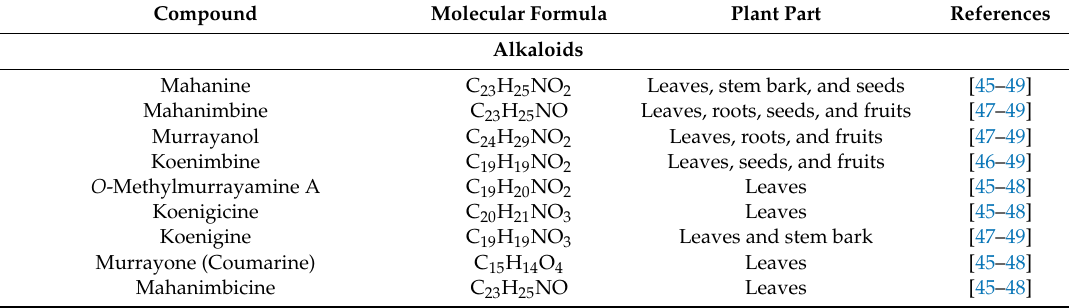
Table 1. Phytochemical compounds identified from M.